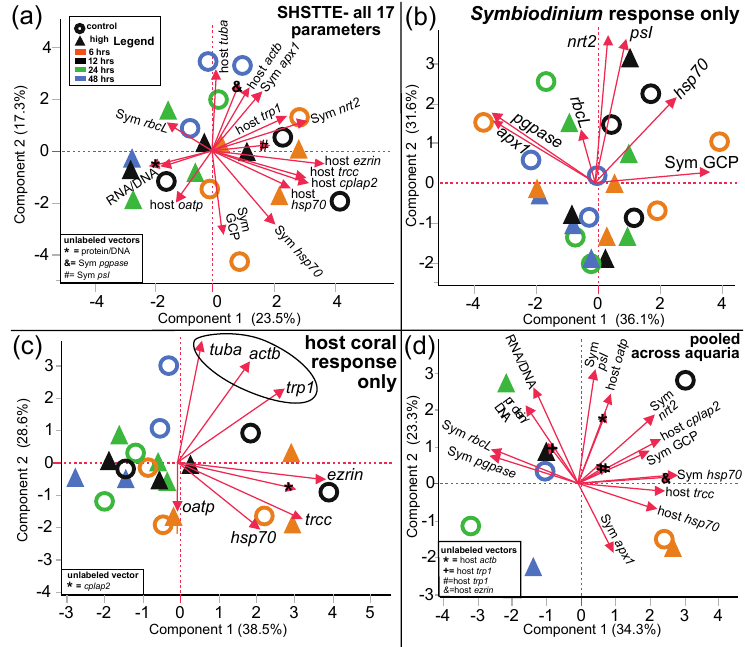
Figure 2. Principal components analysis (PCA) of the Seriatopora hystrix short-term temperature experiment (SHSTTE) dataset. All 17 response variables ( a ), including 3 biological composition parameters (RNA/DNA ratio, protein/DNA ratio, and the Symbiodinium genome copy proportion (GCP)), expression of 6 Symbiodinium mRNAs, and expression of 8 coral mRNAs, were assessed across 20 of the 24 samples (4 samples were omitted due to missing data (see Figure 1.)). All 24 samples were included in the PCA of the Symbiodinium response variables only (GCP + 6 genes; ( b )). For the eight host genes ( c ), the same four samples as in ( a ) were omitted, and the ends of the vectors representing three cytoskeleton genes have been encircled to emphasize their correlation. Data were also analyzed as pooled across aquaria for all 17 parameters for each of the eight temperature × time interaction groups ( d ). The legend in ( a ) applies to all panels.